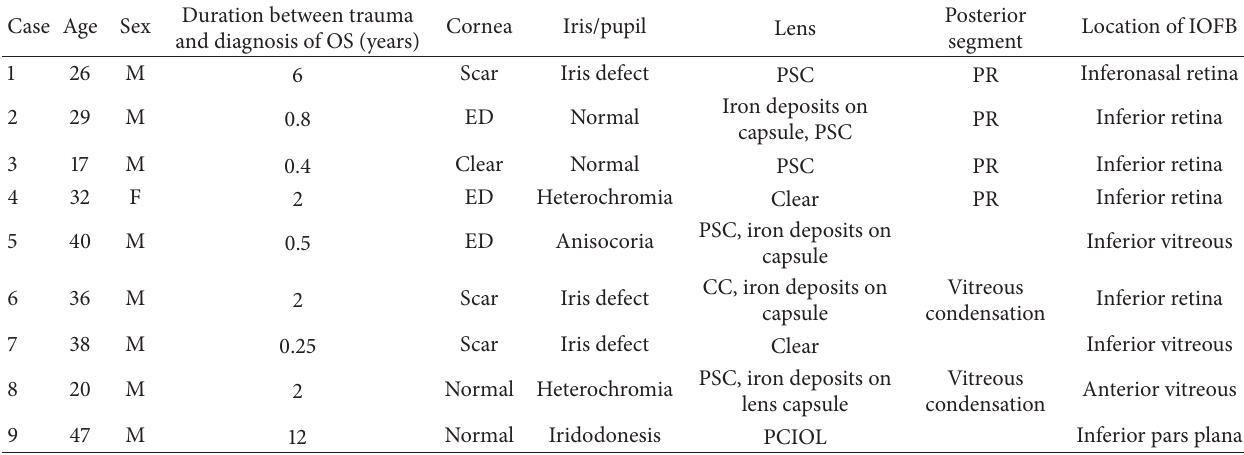
Table 1: Demographic and ocular examination